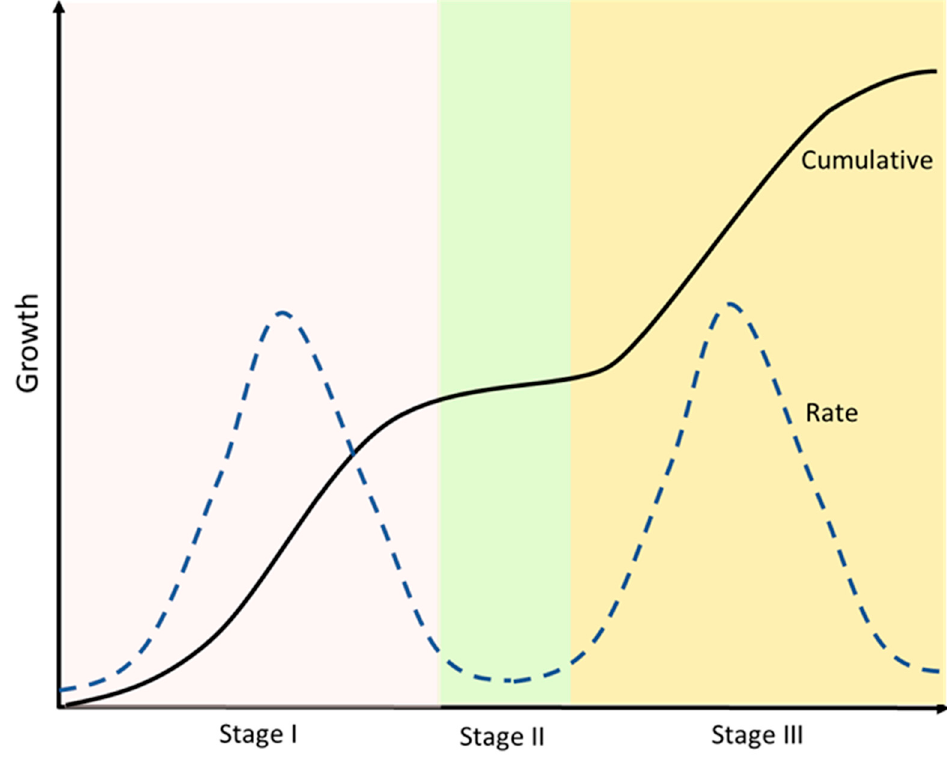
Figure 3. A double sigmoid growth curve representation. Cumulative and rate of growth are defined. After an initial exponential phase (Stage I) a second plateau phase occurs (Stage II), which is followed then by a second exponential phase (Stage III) until the complete ripening of the fruit. Developmental phases are allocated with respect to peaks and troughs in growth rate.